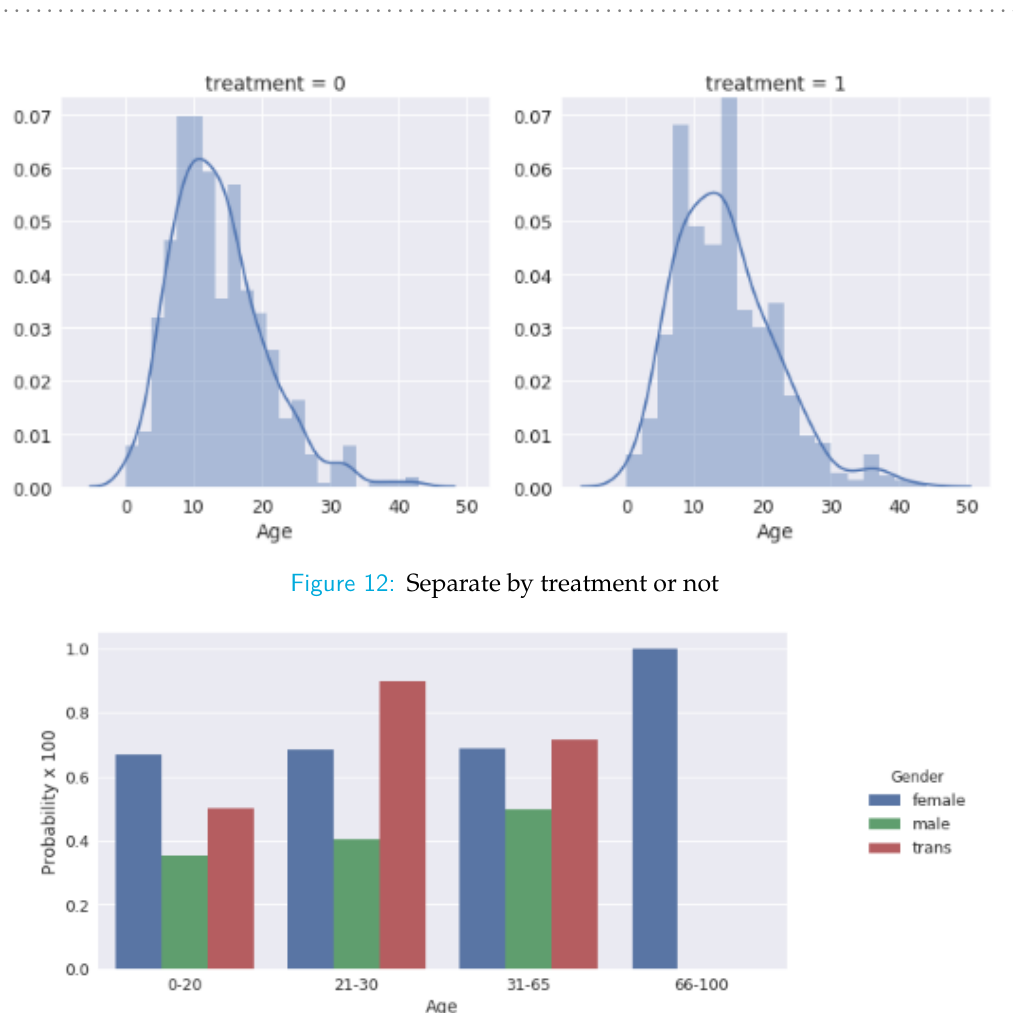
Figure 13: Probability of age-range of mental health condition with care option based on